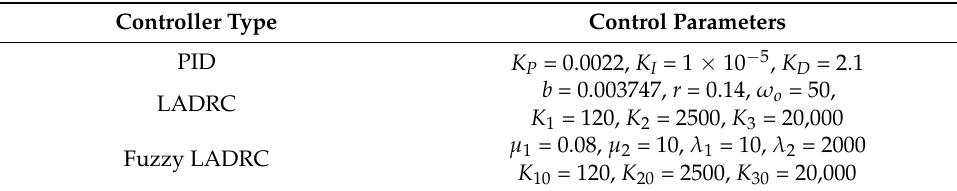
Table 5. Control parameters of different